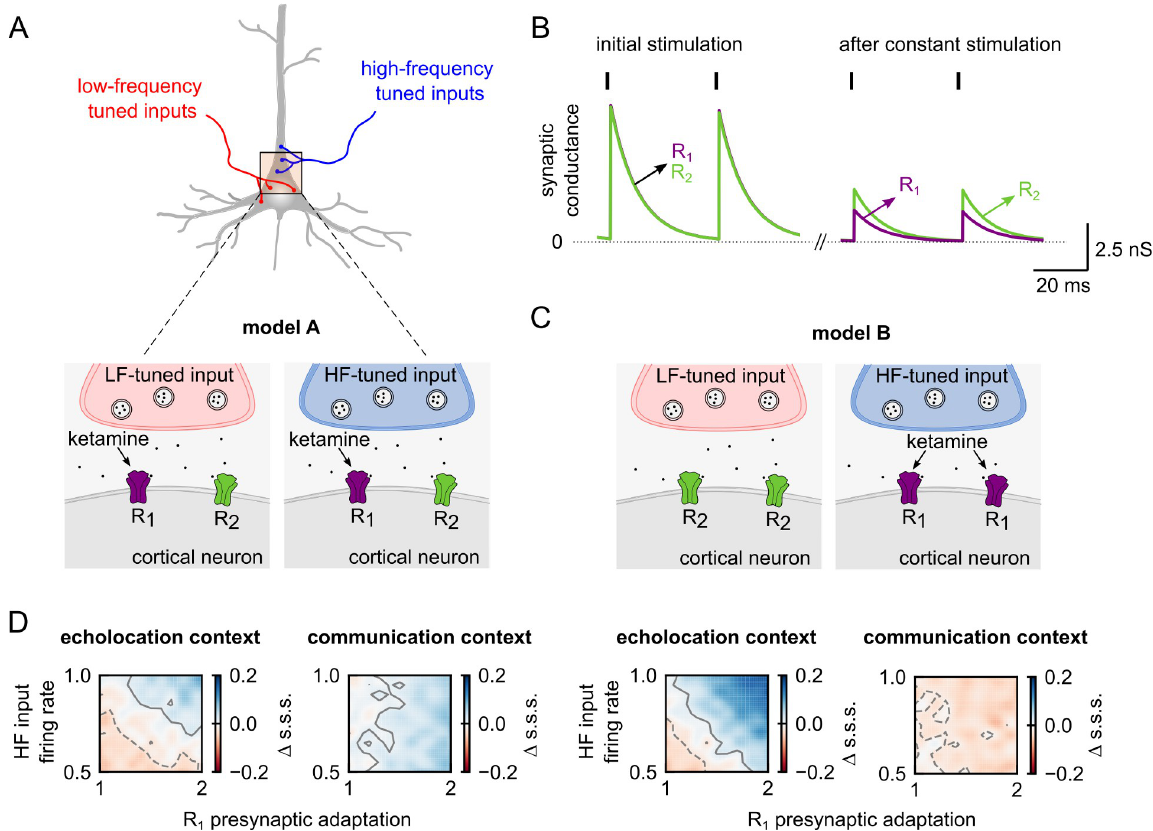
Fig 11. A cortical neuron model with two distinct excitatory conductances provides plausible explanation to channel-specific effects of anaesthesia. ( A ) Diagram of a pyramidal neuron receiving convergent inputs tuned to low- and high-frequency sounds. Bottom: sketch showing the presence of two receptors in the pyramidal neuron (model A). In this model, each cortical input activates receptors R 1 and R 2 . ( B ) Changes in the synaptic conductance associated with each receptor, R 1 and R 2 , in response to a regular spike train at 25 Hz. At the left, the two presynaptic spikes correspond to the third and fourth spikes of the spike train. At the right, two spikes after 1.4 seconds of periodic stimulation. Purple trace corresponds to receptor R 1 in which the adaptation rate is slower than in R 2 (R 2 = green trace). ( C ) Similar to A, but in this case, receptors R 1 and R 2 are associated with cortical inputs with different frequency tuning (model B). ( D ) Below the diagrams of model A and model B, the respective difference in stimulus-specific suppression indices (s.s.s.) between the awake model and different anaesthetized models. The anaesthesia effects were modelled by decreasing HF inputs firing rate and increasing presynaptic adaptation associated with receptor R 1 . Left: after echolocation context; right: after communication context. Contour lines in grey indicate the area with negligible effect size. Positive contours are indicated by solid lines and negative with dashed lines. The anaesthesia effects were implemented as described in Fig 10. Data supporting panel D can be found in “modelA_coefC-HF-d_HF.npy,” “modelA_coefC-HF-d_HF_15-tauth.npy,” “modelB_coefC-HF-d_HF. npy,” and “modelB_coefC-HF-d_HF_15-tauthv2.npy” in “Model” folder in https://gin.g-node.org/Luciana/anesthesia_bats. The underlying codes are in “plots.py” in the same